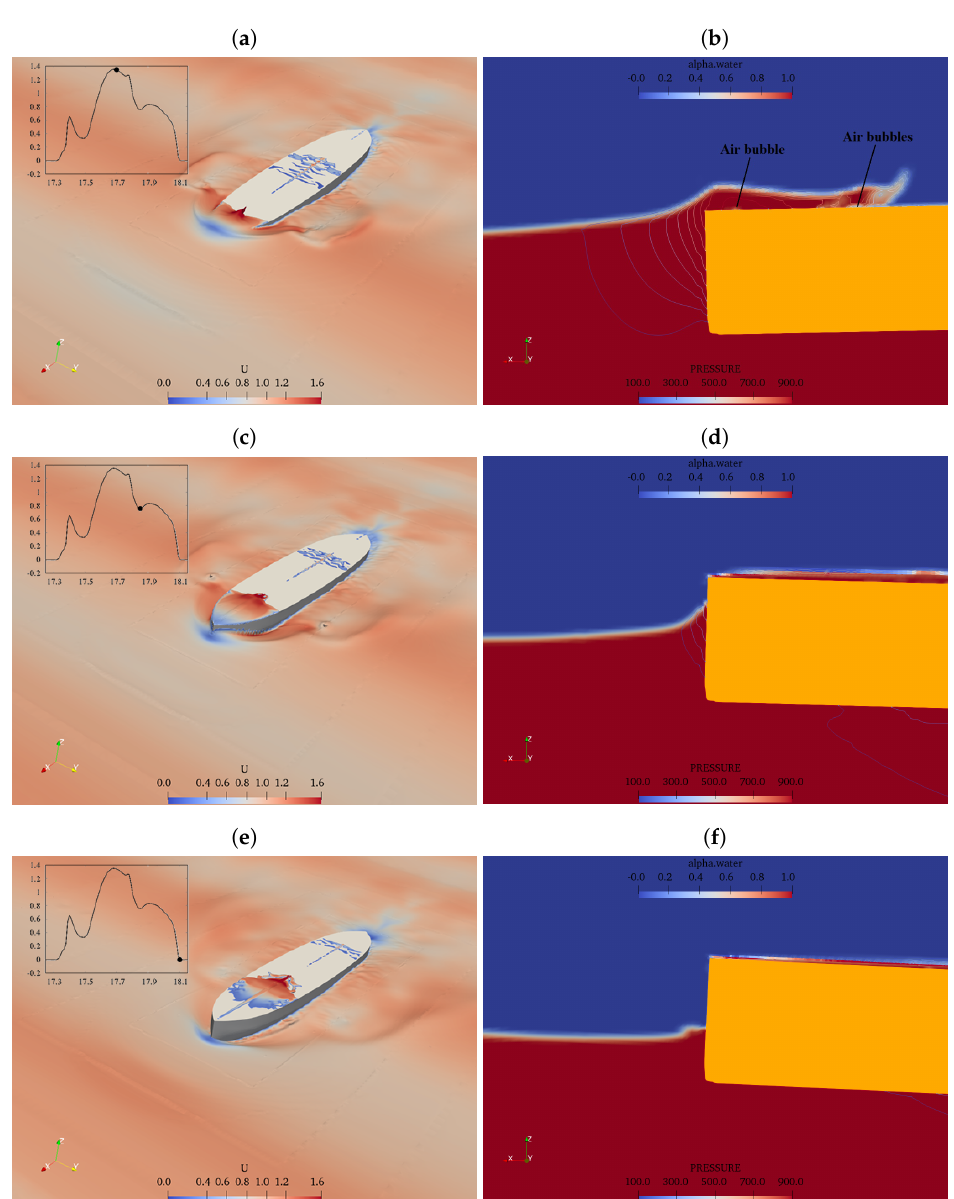
Figure 12. Flow velocity contours on the free surface ( a , c , e ) and pressure contours on the x – z plane at y = 0 ( b , d , f ) at time instants 5–7 for λ / L =